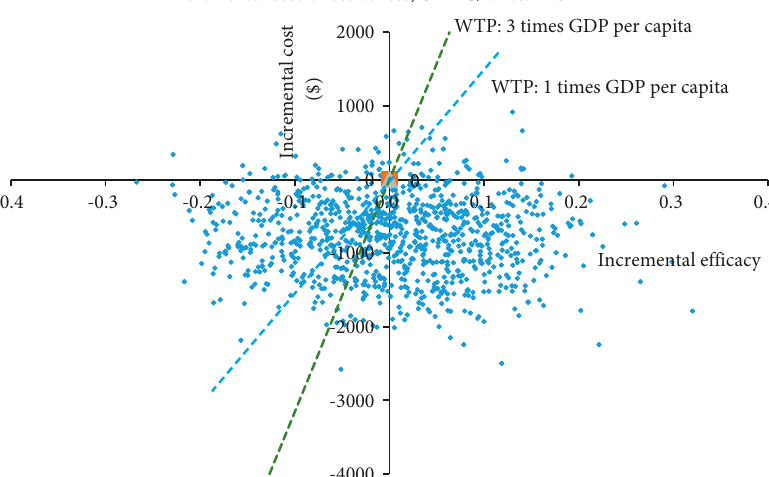
Figure 7: Cost-effectiveness plane for the incremental costs in US dollars compared with the incremental effectiveness in QALYs. Each dot represents a separate run of the model with different input values for each variable randomly selected according to their distribution. According to the Chinese healthcare system, the probability of UMEC/VI being cost-effective was 61.6% at a willingness-to-pay of $31554/